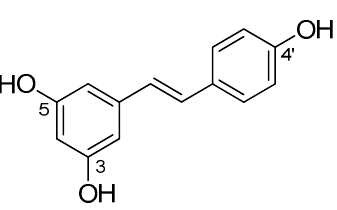
Figure 1. Chemical structure of trans- RSV (3,5,4’-trihydroxy- trans -stilbene).